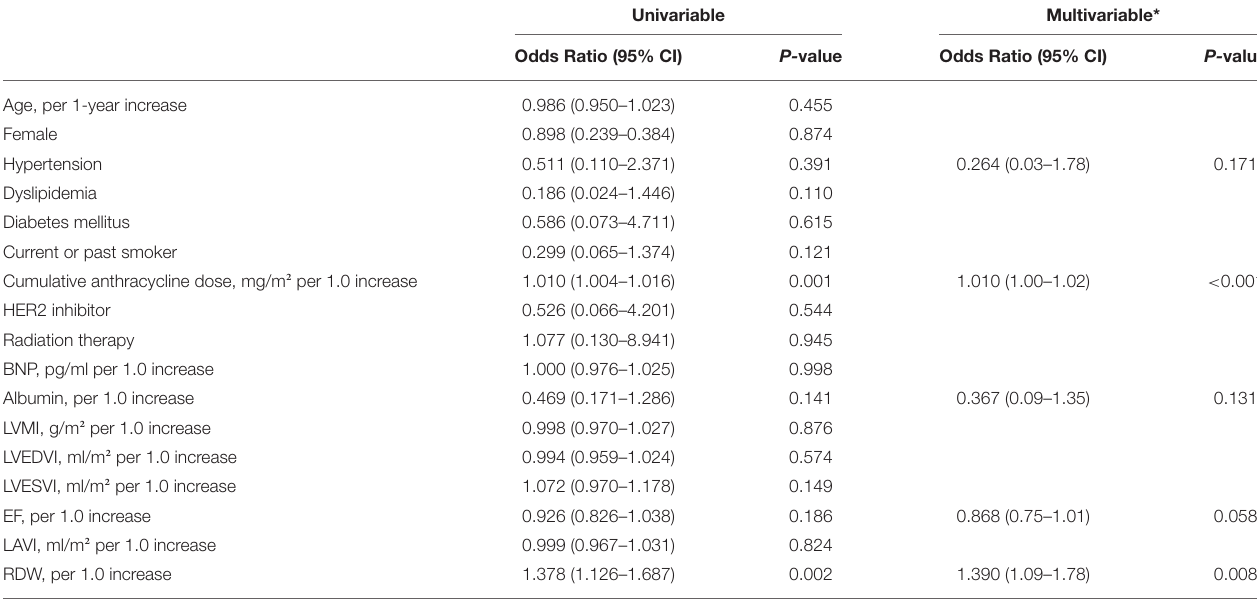
TABLE 2 | Parameters associated with the occurrence of